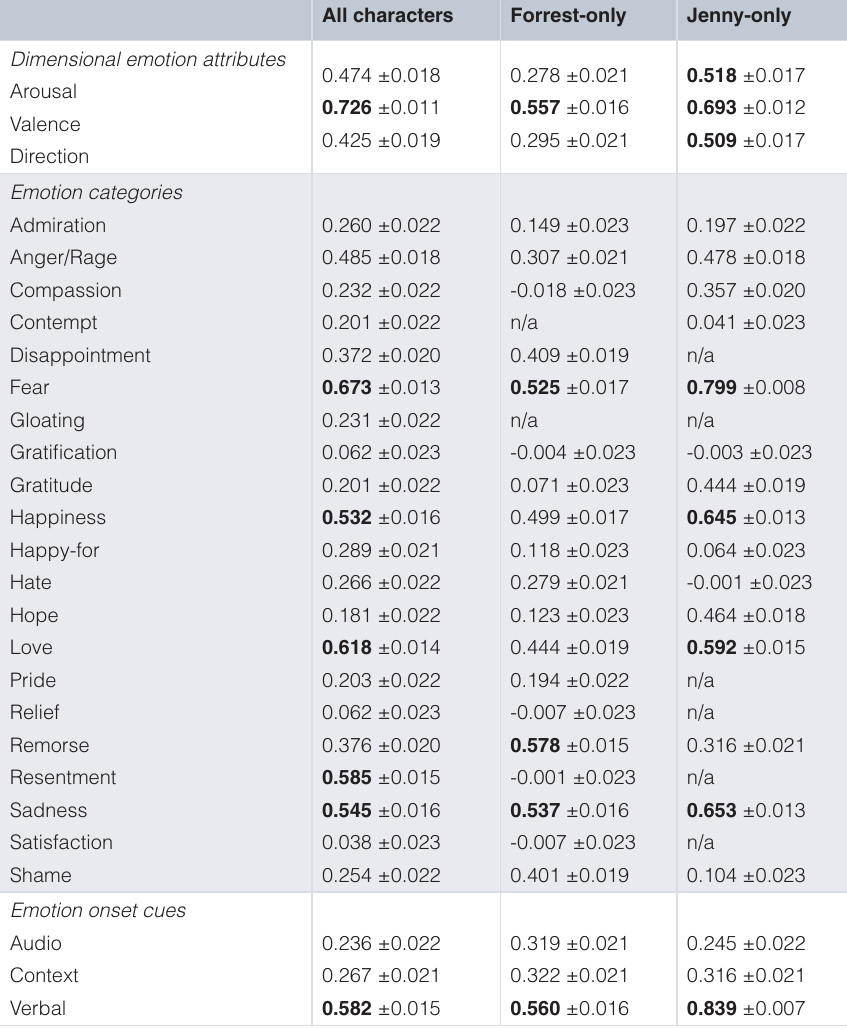
Table 6. Inter-stimulus indicator correlation. All values are Spearman correlations of 1 Hz modulations of the fraction of IOA (as, for example, depicted in figure 3) for the two stimulus types (audio-visual and audio-only movie). The specified range corresponds to the width of the 95% confidence interval of the correlation (computed via Fisher transformation). Correlations higher than 0.5 (arbitrary threshold) are depicted in bold for visualization purposes. n/a fields indicate an insufficient number of annotations to compute the consistency measure. All characters Forrest-only